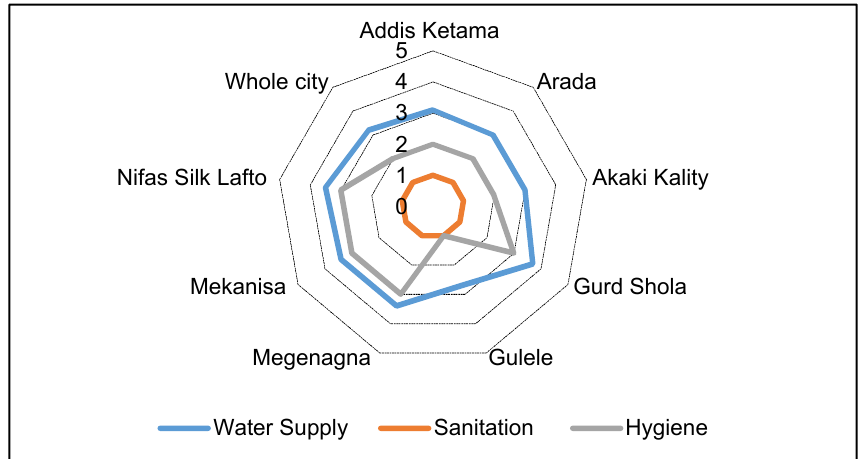
Figure 8. Domestic water security index of each of the dimensions for branch in 2017.